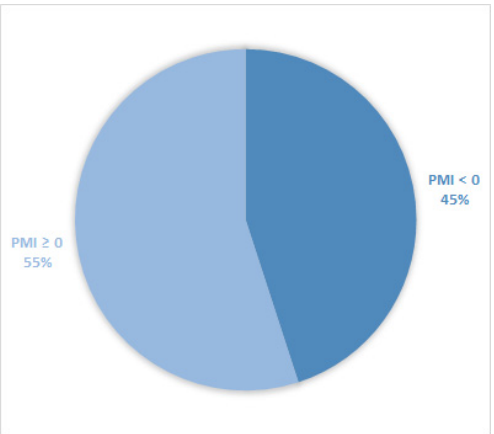
Figure 2. Pie chart displaying the percentage of patients with PMI < 0 and PMI ≥ 0. Only patients with pain or receiving analgesics were included (1417).